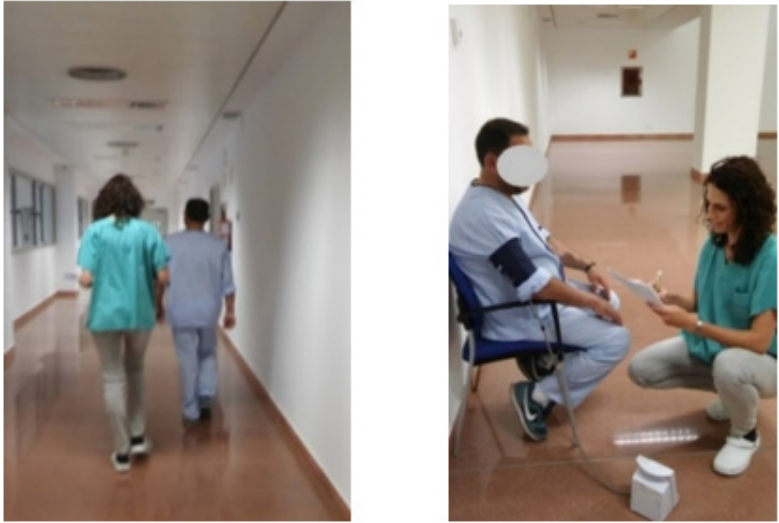
Figure 10. Six-Minute Walk Test (reproduced with permission from Erika Meléndez-Oliva 2020) [43].